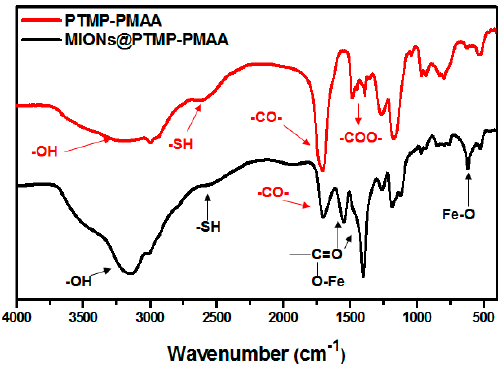
Figure 5. Fourier transform infrared spectroscopy (FTIR) spectra of PTMP-PMAA and